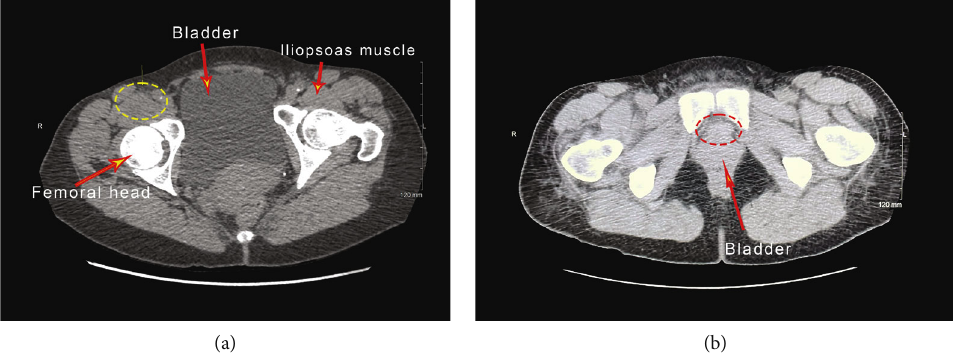
Figure 1: CT scan of the abdomen and pelvis demonstrating a psoas abscess ((a) yellow circle) and a 20 × 15 × 14 mm soft tissue density in the inferior posterior left paramedian bladder wall ((b) red circle).